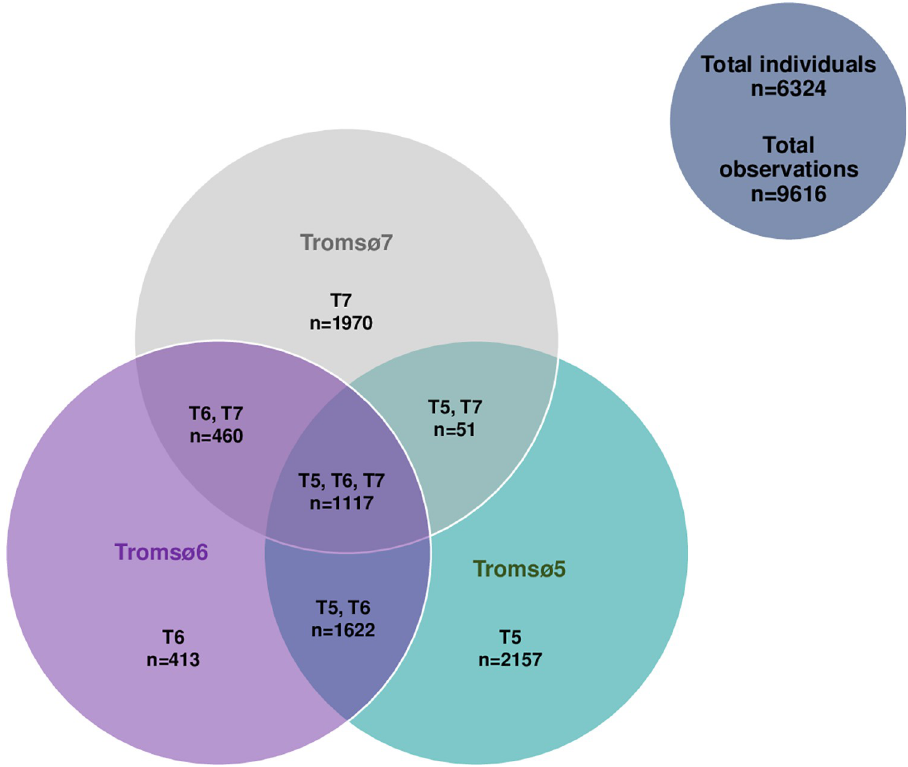
Fig 1. Number and distribution of the participants in the Troms ø Study surveys Troms ø 5, Troms ø 6 and Troms ø 7.